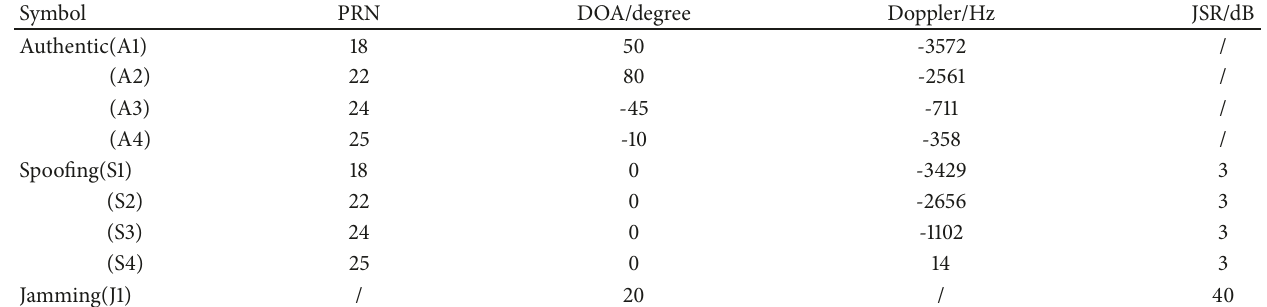
Table 1: Parameters of satellite and interference.